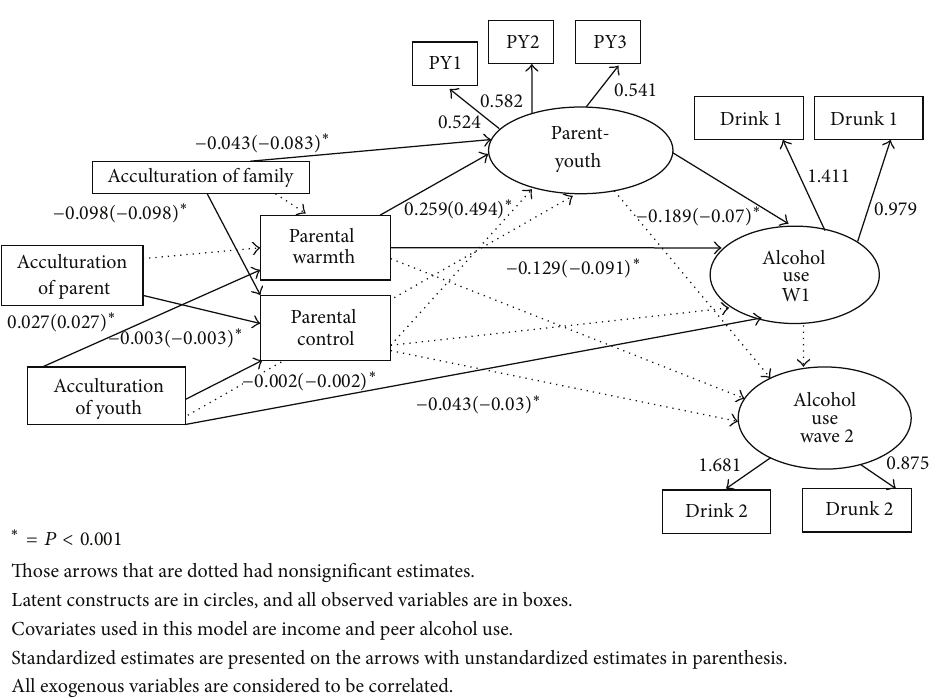
Those arrows that are dotted had nonsignificant estimates. Latent constructs are in circles, and all observed variables are in boxes. Covariates used in this model are income and peer alcohol use. Standardized estimates are presented on the arrows with unstandardized estimates in parenthesis. All exogenous variables are considered to be correlated. Figure 1: SEM model for explaining the relationship between parenting style, acculturation, and alcohol use in Mexican American